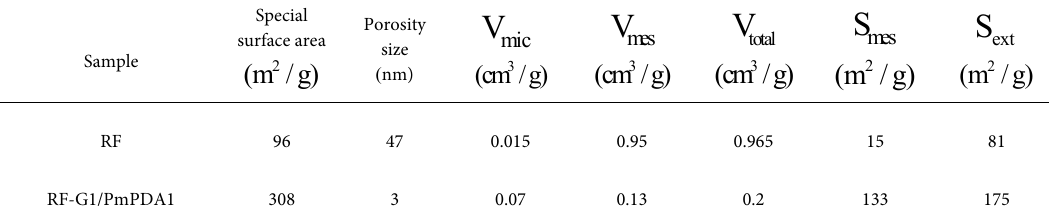
Table 3. Surface area, pore size, and pore volume parameters for RF and RF-G1/PmPDA1 Special Sample